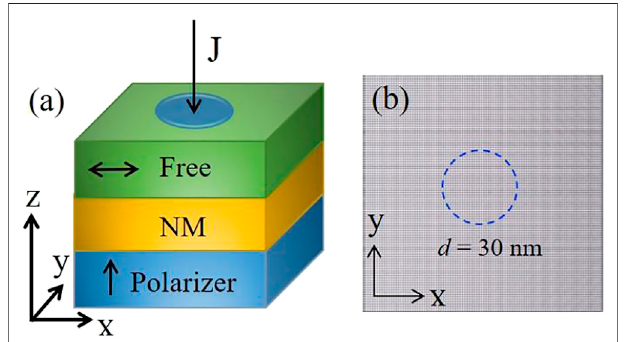
FIGURE1 | (Color online) (A) Schematic diagram ofthe STO nano-pillar. The free layer has an in-plane magnetic anisotropy. (B) Snapshot of the groundstateofthefreelayer,wherethemagnetizationofthefreelayerisalong the+ x direction.Grayisthebackgroundcolor.Thecentralcircularregion with 30 nm in diameter indicates the regime of applied current.